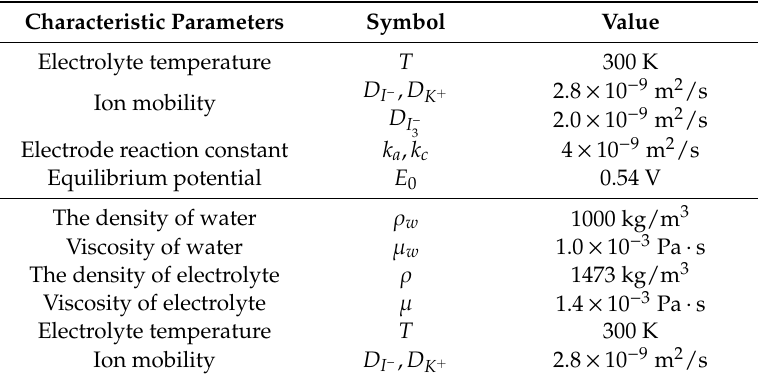
Table 1. Parameters of simulation